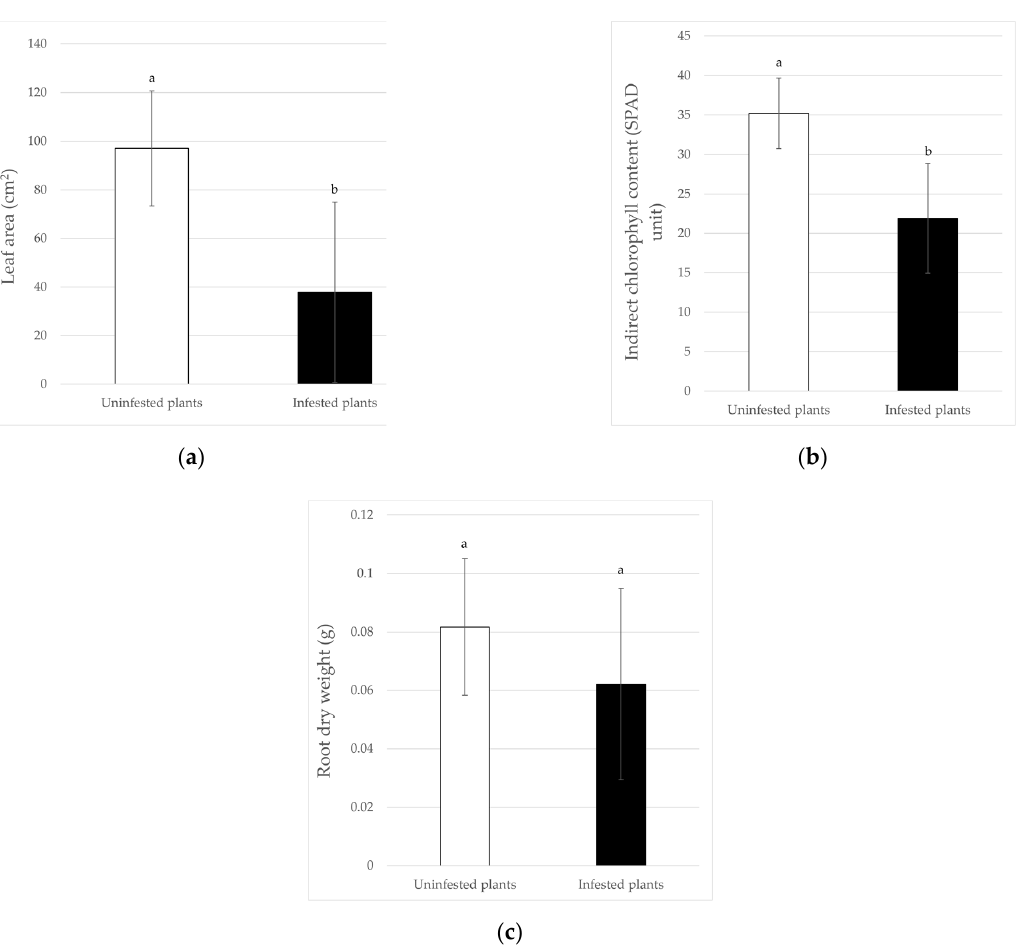
Figure 2. Incidence of B. tabaci infestation on the height ( a ) and shoot dry weight ( b ) of tomato plants. Different letters indicate statistically significant differences at p < 0.01 ( a ) and p < 0.05 ( b ).